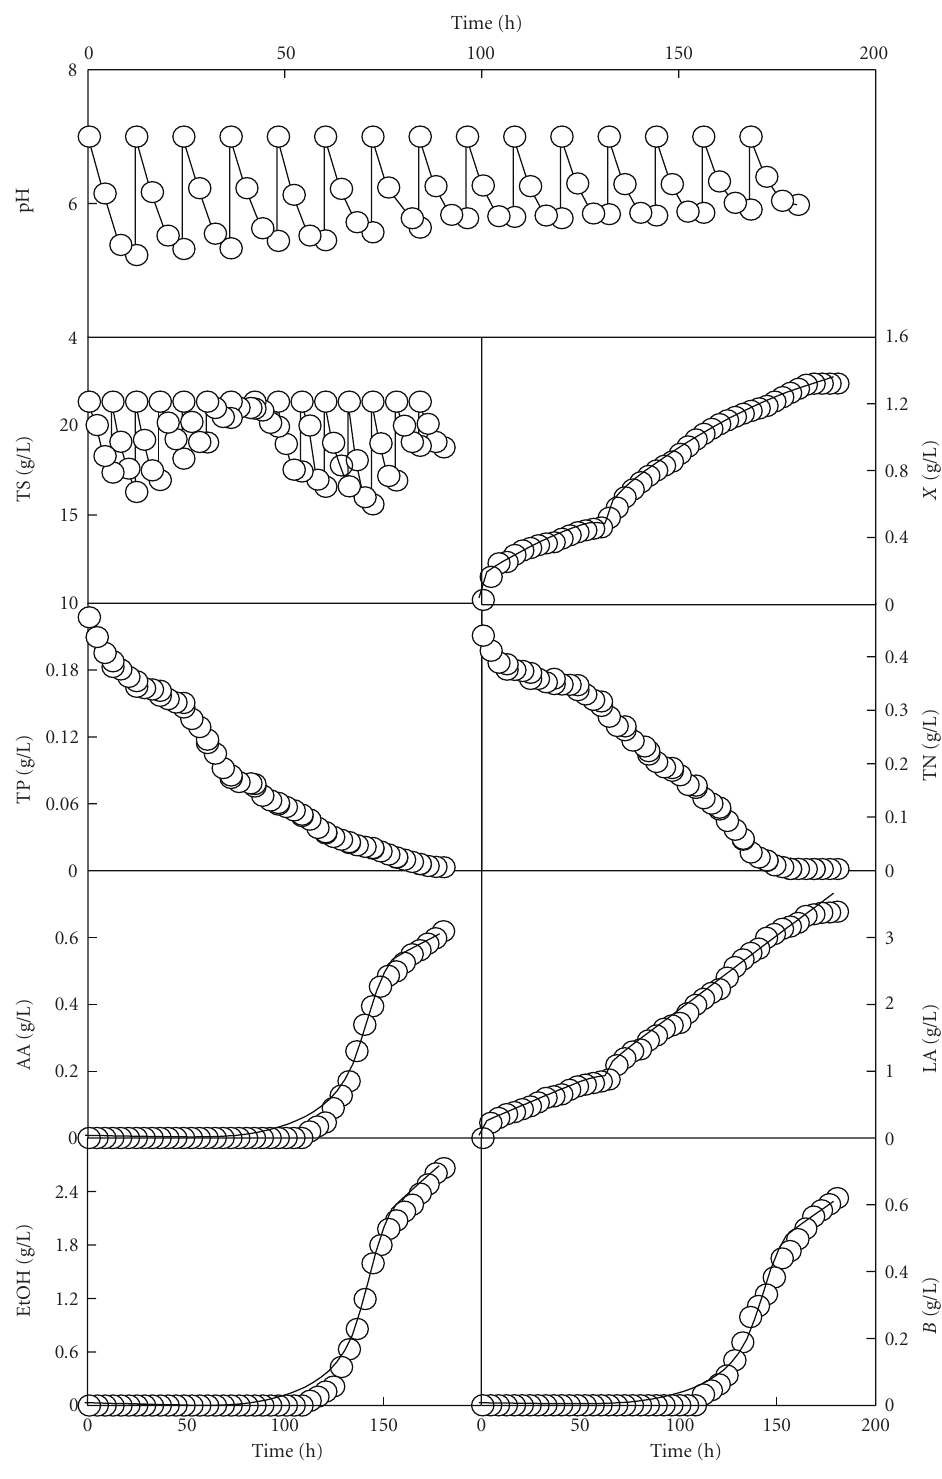
Figure 3: Time course of the realkalized fed-batch culture of Ent. faecium CECT 410 on whey with feeding with a 400 g/L concentrated lactose (fed-batch fermentation I). AA: acetic acid, EtOH: ethanol, B: butane-2,3-diol. Other notations are as in Figure 1. Data reported are means ± standard deviations of three replicates. The solid lines drawn through the experimental data of biomass and lactic acid were obtained according to the models (A.6) and (A.7), respectively. The solid lines drawn through the experimental data for AA, EtOH, and B were obtained according to the model